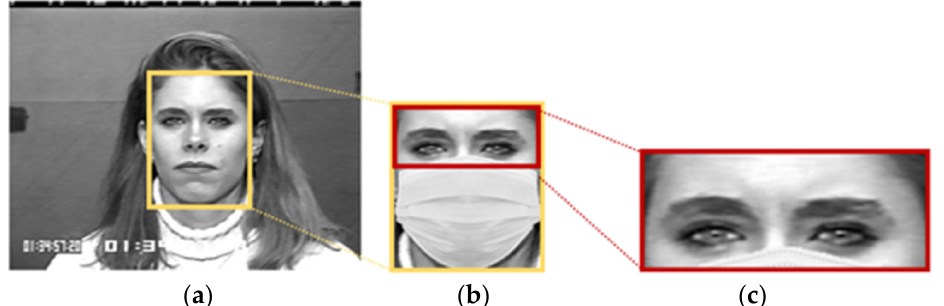
Figure 9. Upper face detection; ( a ) CK+ original image; ( b ) face detected using Dlib with the overlapping synthetic facial mask; ( c ) detected upper face.